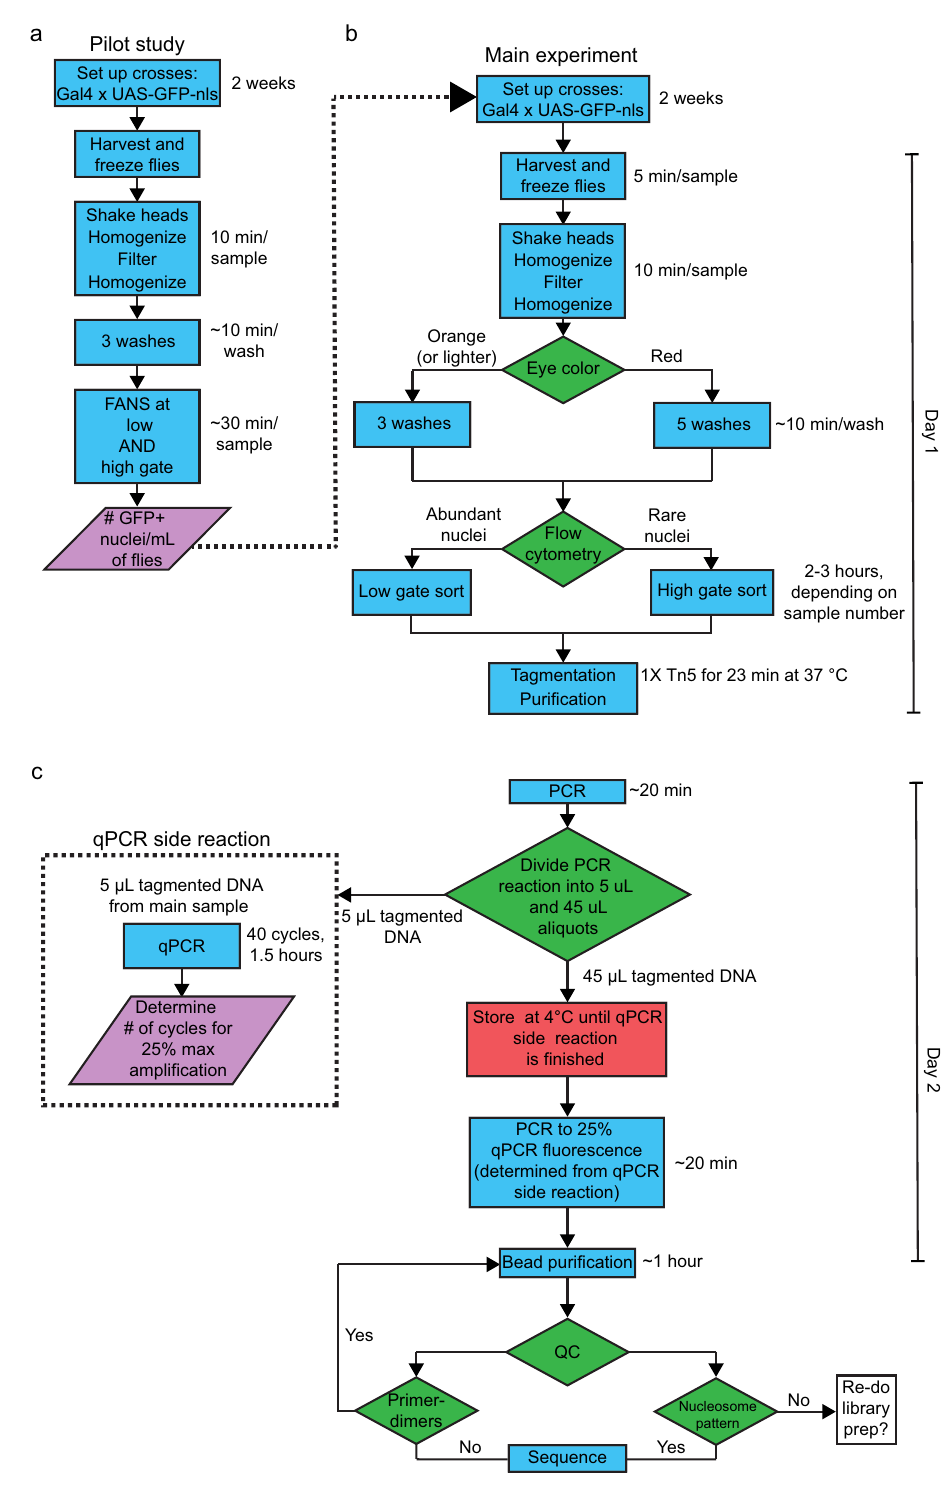
Figure 8. Flow chart of ATAC-seq library preparation from Drosophila nuclei. Suggested workflow, which we routinely use to generate ATAC-seq libraries from adult Drosophila . The libraries prepared using the workflow conform to ENCODE guidelines, with typical markers indicating a high-quality library, including nucleosomal banding patterns, high genome alignment rates, and high fraction of reads in peaks (FRiP). ( a ) Pilot study to determine inputs and parameters for the main experiment. ( b ) Nuclei isolation and tagmentation reaction. ( c ) Library amplification and purification. In the workflow, blue boxes indicate procedural steps, green diamonds indicate decision points, purple slanted boxes indicate information that inform steps in the main experiment (dotted lines), and the red box indicates a safe stopping point. On the right of each procedural box is shown the approximate time required for each